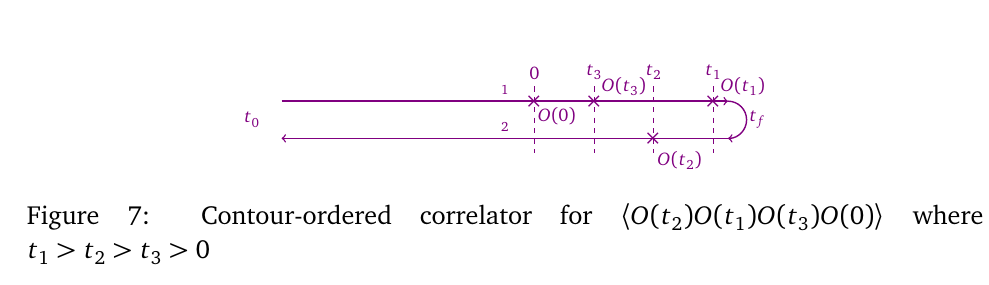
Figure 6: Contour-ordered correlator for 〈 O ( t > t > t > 0 t 1 2 3